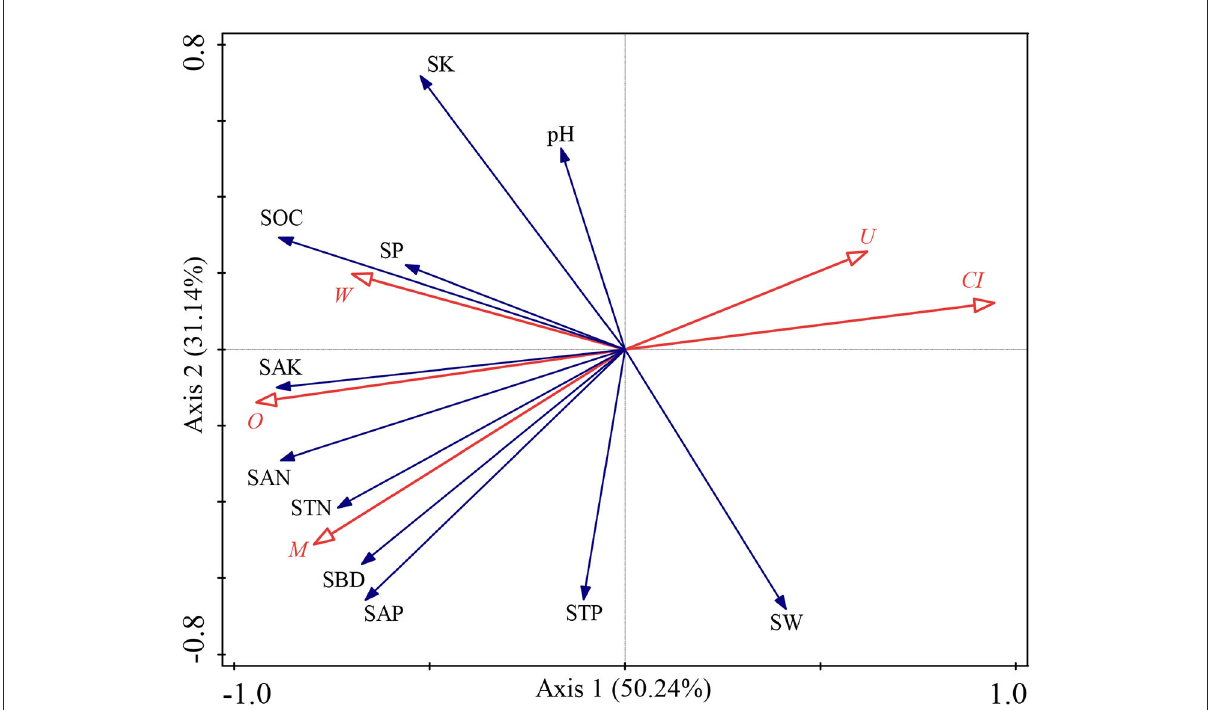
FIGURE4 Redundancy analysis (RDA) among the stand spatial structure characteristic indexes and environmental factors. The angle between the two indicators represents a significant and positive relationship (acute angle, < 90 ◦ ) or negative relationship (obtuse angle, > 90 ◦ ). The length of the arrows is proportional to the magnitude of the standardized path coefficients (i.e., the strength of the relationship). The stand spatial structure parameters are M , mingling index; W , uniform angle index; CI , competition index; U , neighborhood comparison; and O , opening degree. The soil parameters are SOC, soil organic carbon; STN, soil total nitrogen; SAN, soil alkaline nitrogen; STP, soil total phosphorus; SAP, soil available phosphorus; SK, soil total potassium; SAK, soil available potassium; SW, soil water content; pH, soil pH; SBD, soil bulk density; SP, soil